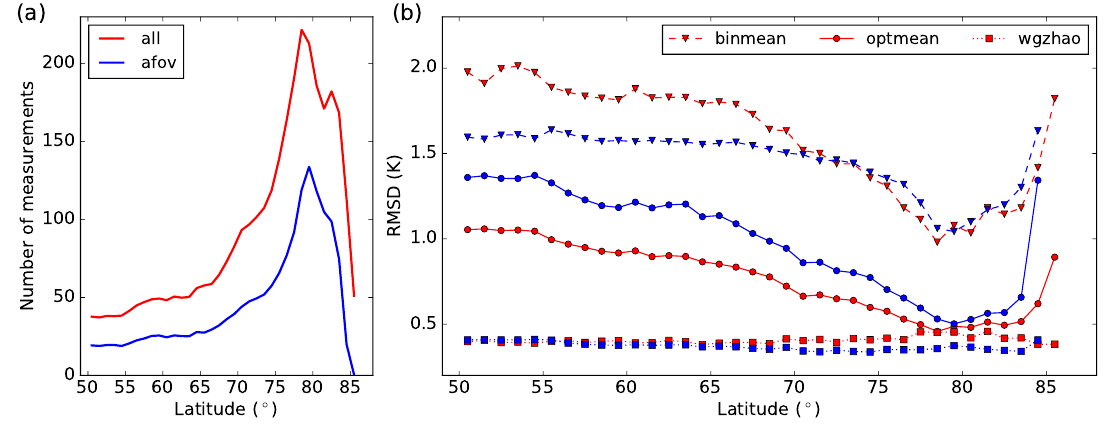
Figure 6. RMSD between modeled and fitted TBs as a function of latitude for the binmean , optmean and wgzhao methods ( b ). Blue lines are results based on AFOV data and red lines are based on data from whole snapshots. The number of measurements as a function of latitude used to assign RMSD values to each latitude are shown in ( a ).